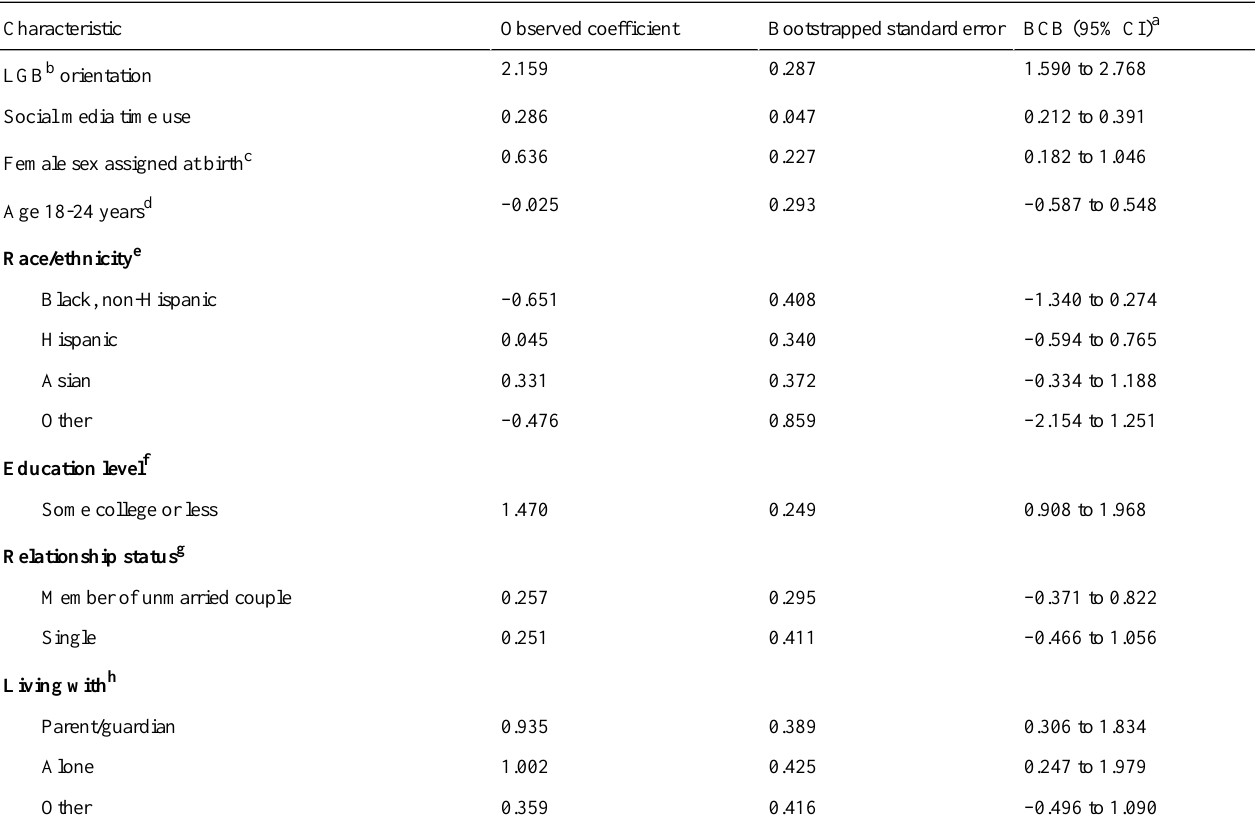
Table 2. Generalized structural equation model (GSEM) results for conditional direct effects of LGB orientation and depressive symptoms (path c model)